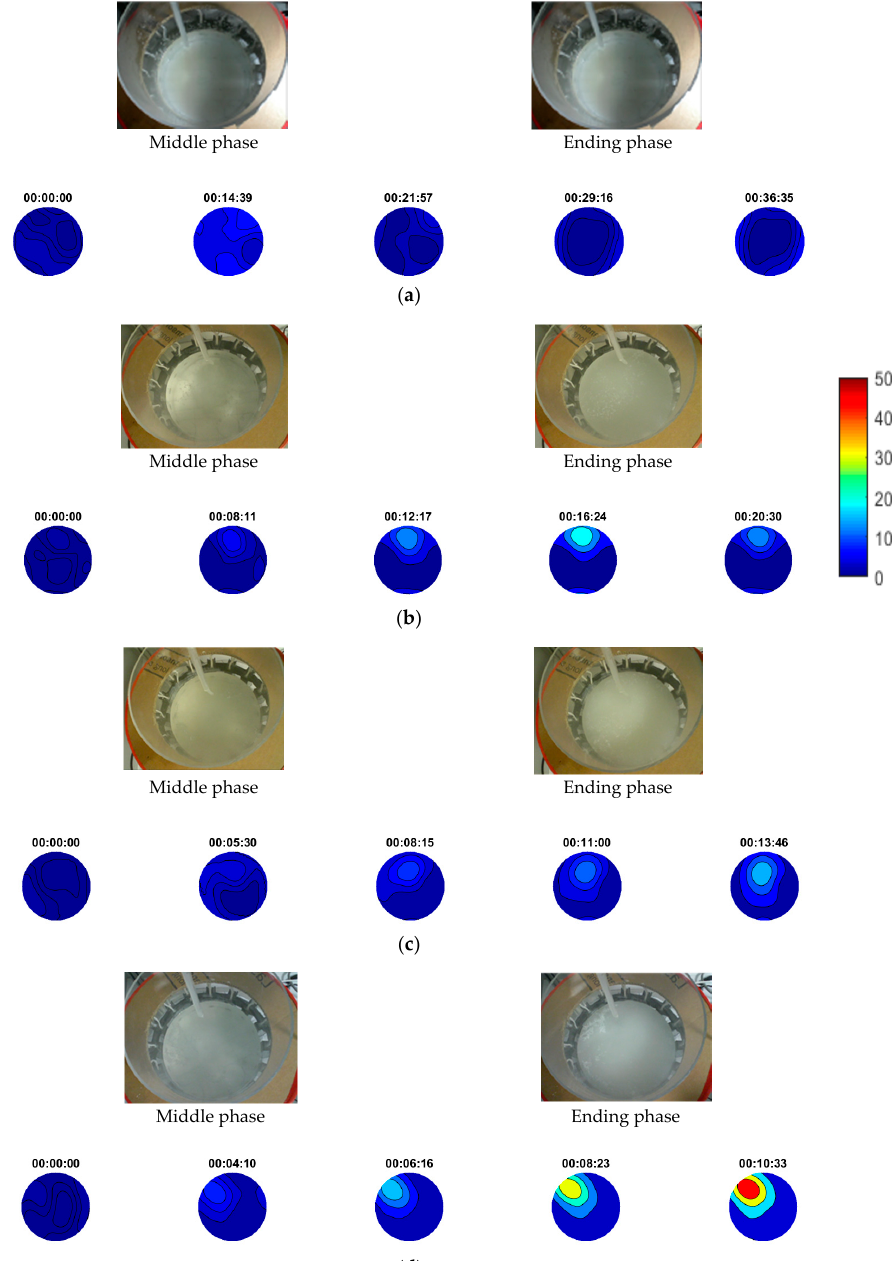
Figure 12. Reconstructions of stirring calcium carbonate crystallisation experiments with ( a ) 9 mL/min, ( b ) 18 mL/min, ( c ) 27 mL/min and ( d ) 36 mL/min injection rate. Stirring rate was at 100 rpm using magnetic stirrer. Note a uniform image scale bar is used for all four sets of experiments to provide comparative evaluation. Scale bar describes pulses’ travel-time delays.